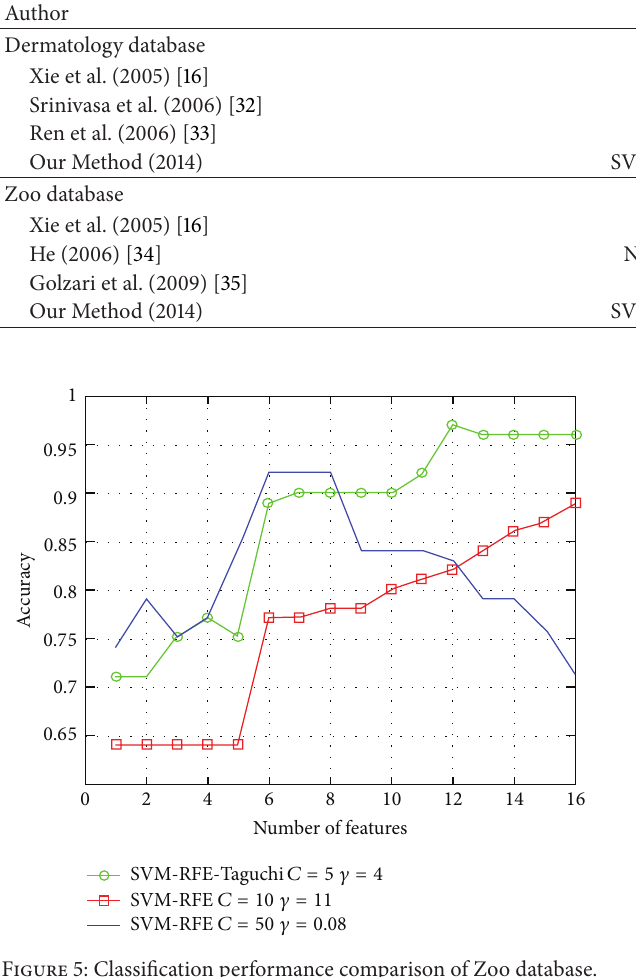
Figure 5: Classification performance comparison of Zoo